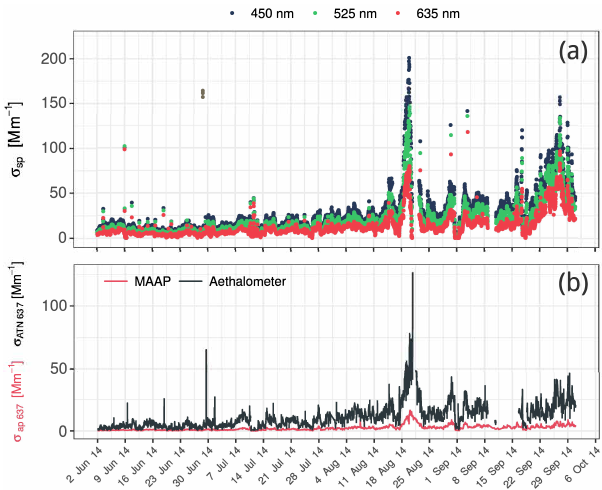
Figure 1. Time series (June–September 2014) of (a) scattering by aerosol particles measured by the nephelometer and (b) Aethalome- ter attenuation and MAAP absorption coefficient measurements at 637nm during the sampling